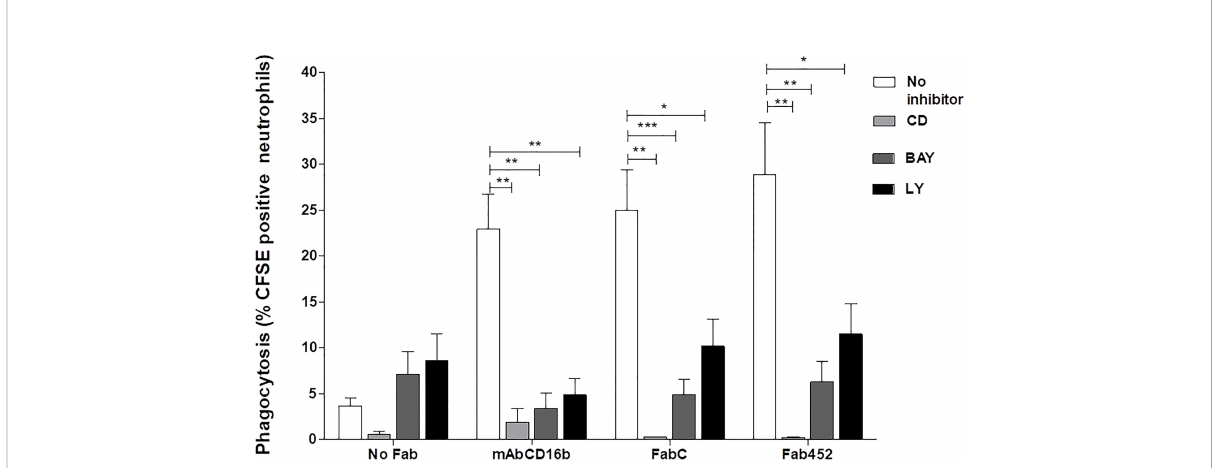
FIGURE 3 CD13-mediated phagocytosis requires actin reorganization and Syk and PIK3 activities. Neutrophils were incubated with 10 µg Fab fragments of mAb452 or mAb C (anti-CD13), with 10 µg of mAb G8 (anti-Fc g RIIIb), or without antibody (no Fab) for 30 minutes at 4°C. After washing, cells were incubated with 5 µM cytochalasin D, 10 µM BAY, or 20 µM LY294002, or DMSO as vehicle control for 20 min at 37°C. Then, cells were incubated for 1 hour at 37°C with EBS-Fab. Non ingested erythrocytes were lysed and samples were analyzed by fl ow cytometry to determine the percentages of CFSE-positive cells. The bars show the mean ± SEM of CFSE-positive cells from 5 independent experiments for cytochalasin D, and from 11 experiments for the pharmacological inhibitors of kinases (BAY and LY294002). *p<0.05, **p<0.01,